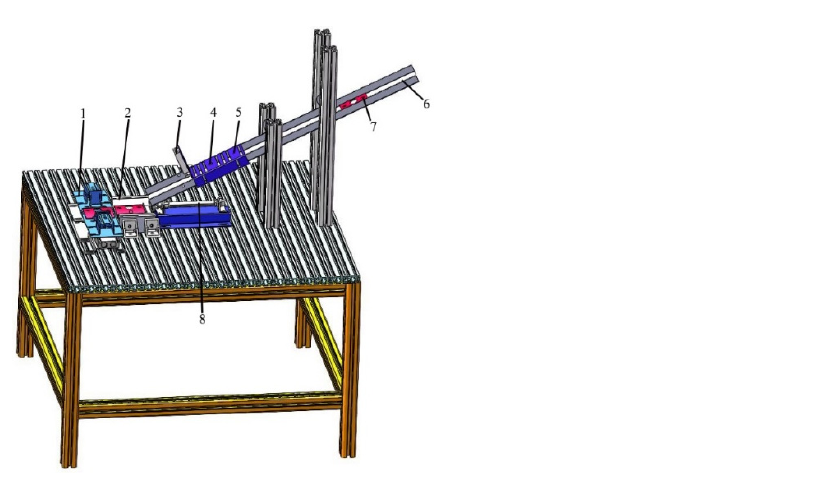
Figure 12. Structure diagram of the girdle feeding mechanism. 1. Welding area; 2. girdle blanking waiting for area; 3. cylinder; 4. inductive proximity switch; 5. electromagnet; 6. storage chute; 7. girdle; 8. mini cylinder. 7. girdle; 8. mini